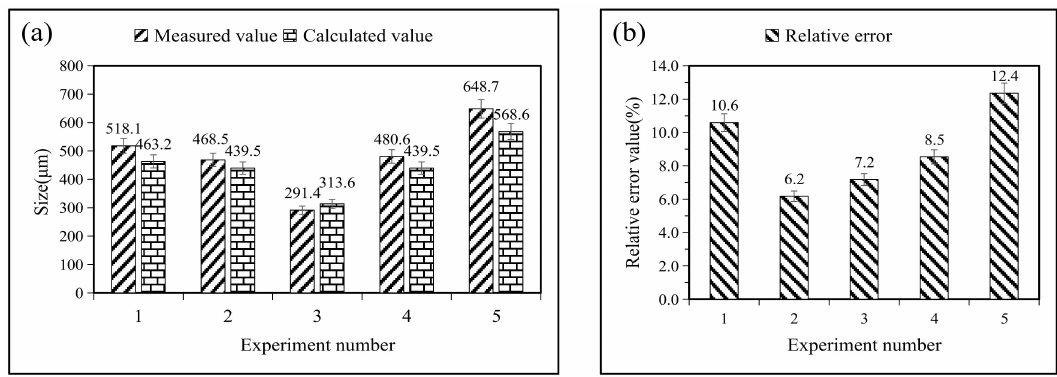
Figure 12. Error verification of Equation (8) (( a ). comparison of measureed value and calculated value; ( b ). corresponding relative error).